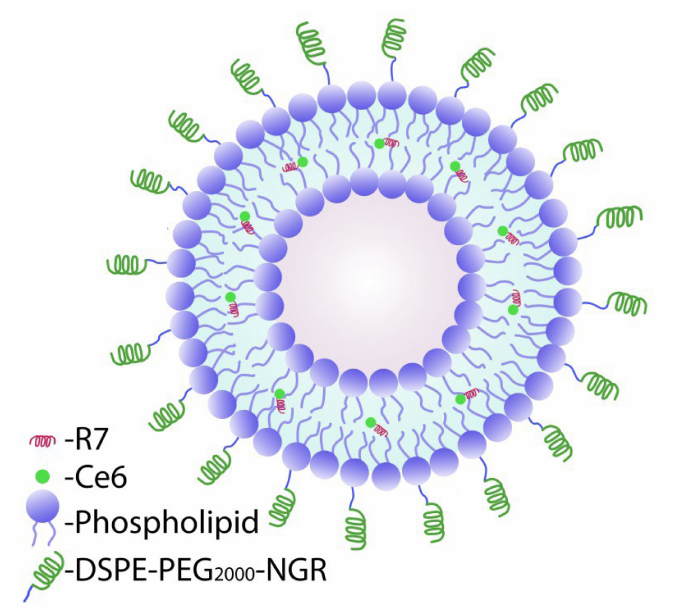
Scheme 1. Model of the Ce6 incorporated to phospholipid system with